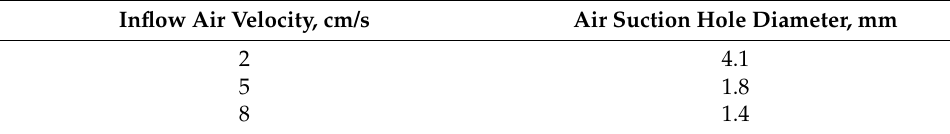
Figure 6. Picture of air sampling ports and port hole.